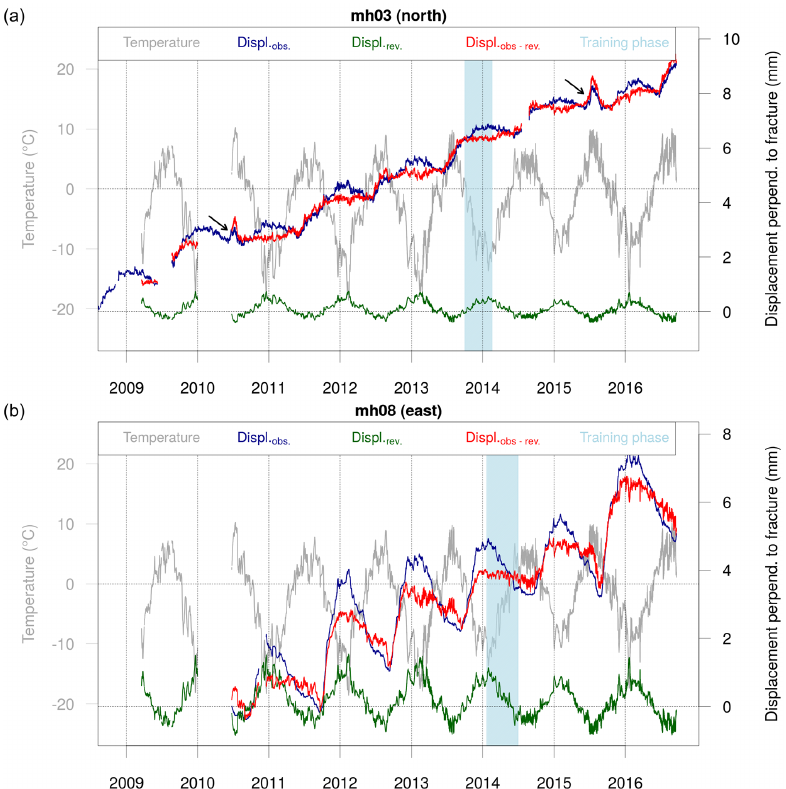
Figure 8. Linear regression model (LRM; green) applied to the observed displacements (blue) perpendicular to the fracture at location mh03 (a) and mh08 (b) . The reversible component (green) due to thermoelastic strains in rock can be modeled by a LRM with temperature (dark gray) and displacement measurements during a training period of several months (light blue shading) as input data. Subtracting these reversible displacements from the observed data results in the red line, referred to as irreversible fracture